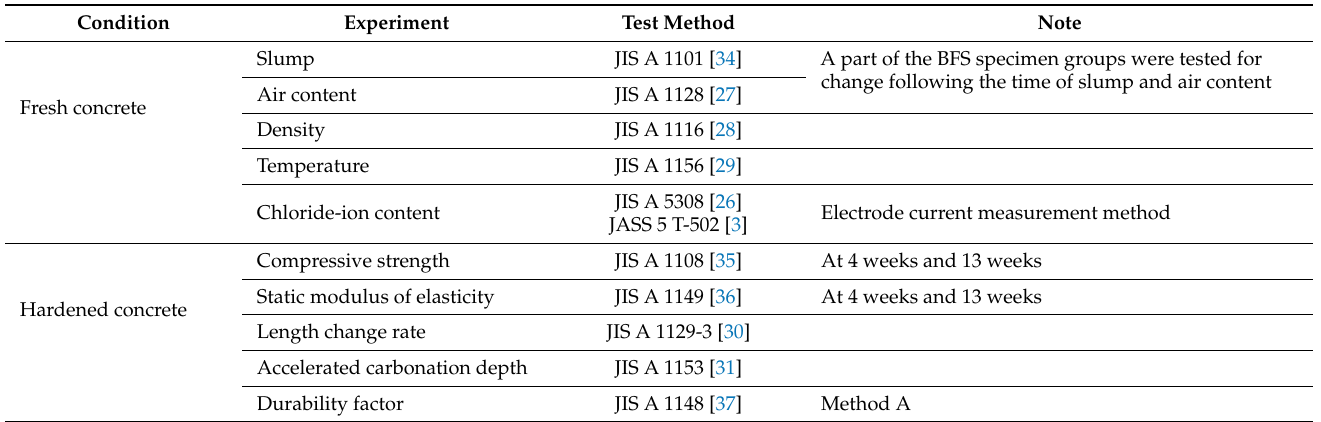
Table 9. Experiment and test method of concrete.